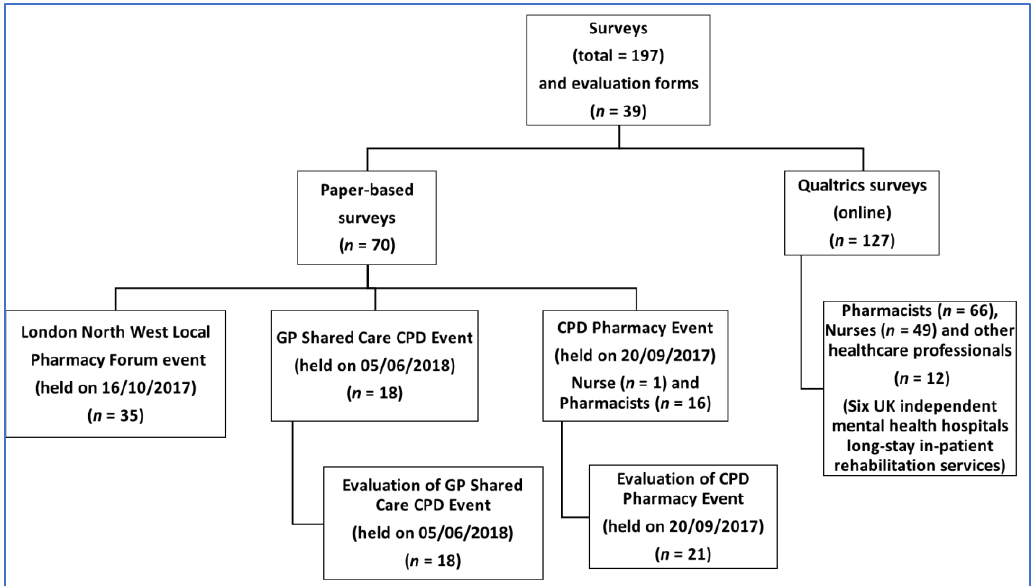
Figure 1. Survey distribution flow chart.